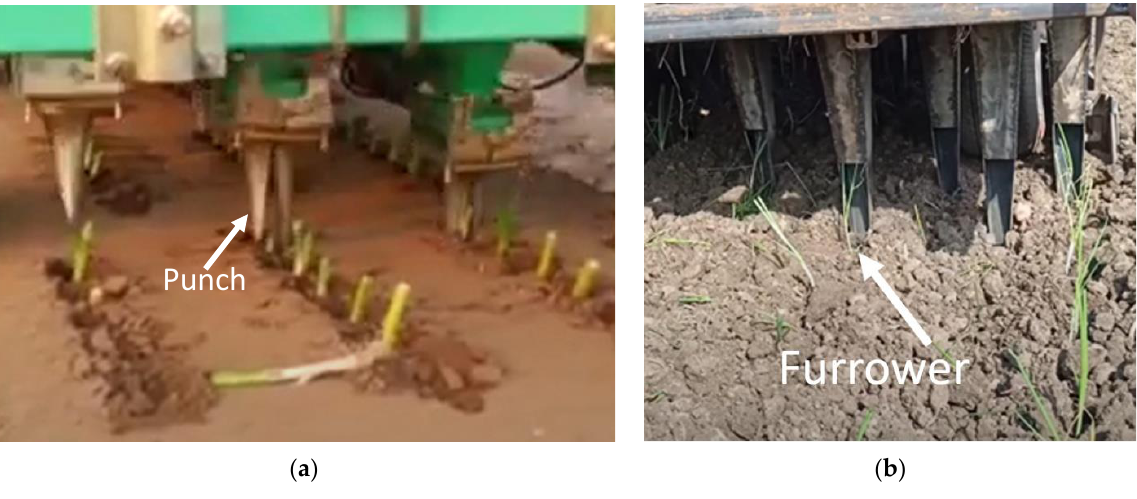
Figure 7. ( a ) Punch mechanism [13]; ( b ) Furrower [14].